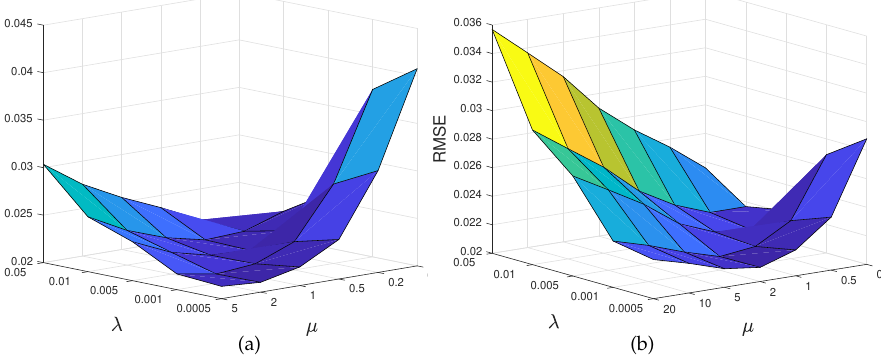
Figure 3. RMSE as a function of the regularization parameters for the proposed method with S 1 using Polynomial